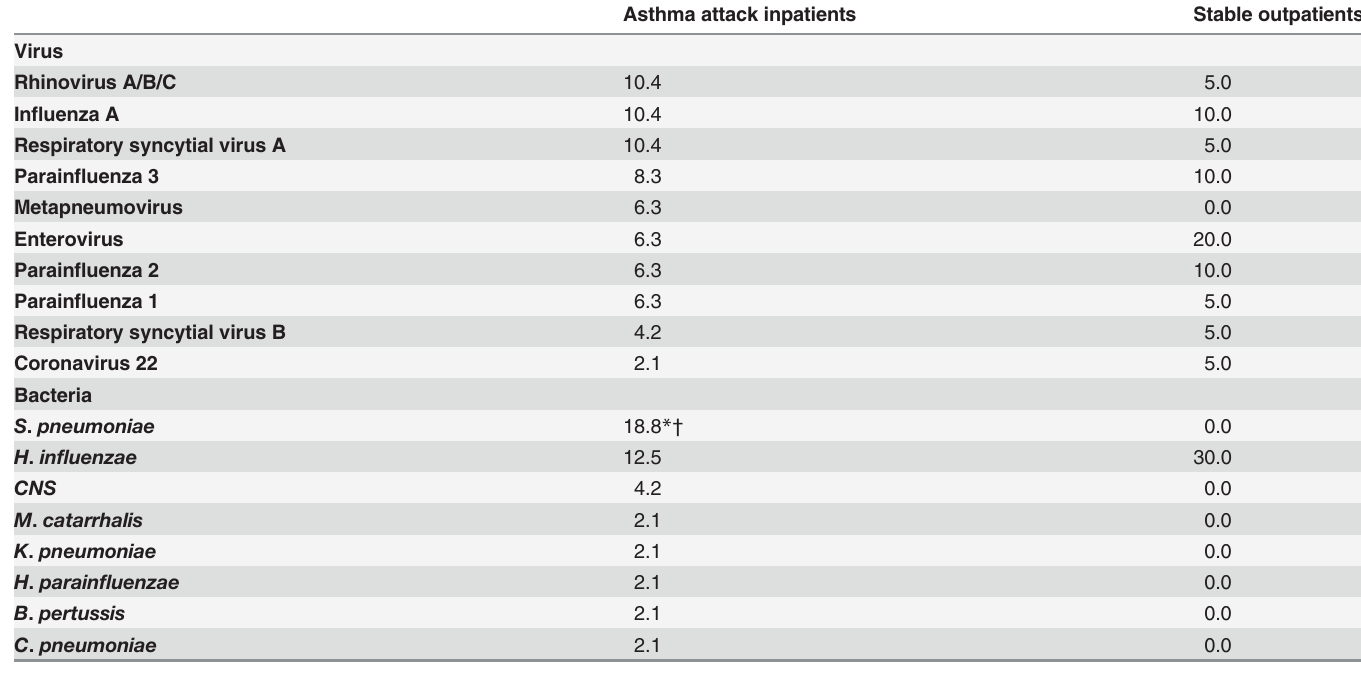
Table 4. Pathogen detection between asthma inpatients (exacerbation) and stable outpatients